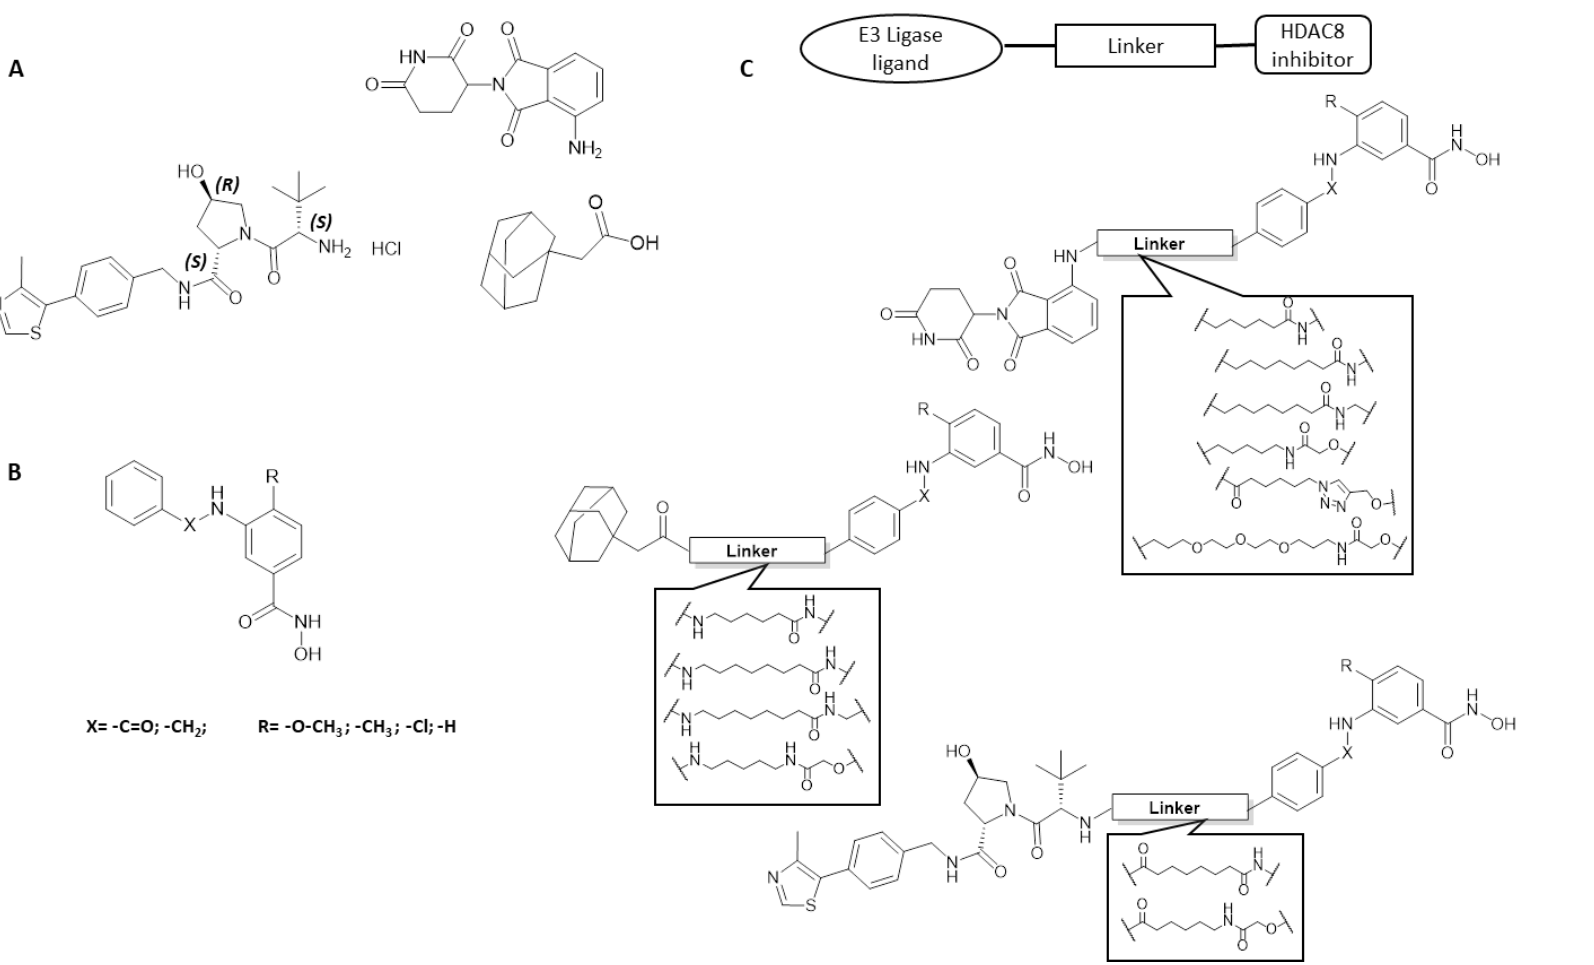
Figure 4. ( A ). Structure of E3 ligase ligands pomalidomide and VHL ligand as well as the adamantyl derivative HyT group. ( B ). General structure of HDAC8 inhibitors. ( C ). Schematic representation of designed HDAC8 PROTACs.